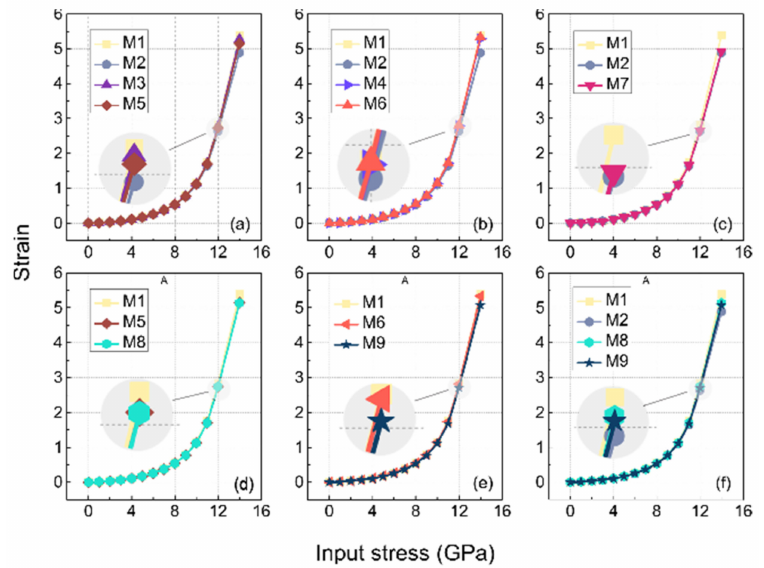
Figure 14. Uniaxial tensile stress–strain curve of EPDM models with different cross-linking, ( a – f ) are drawn for the same purpose as in Figure